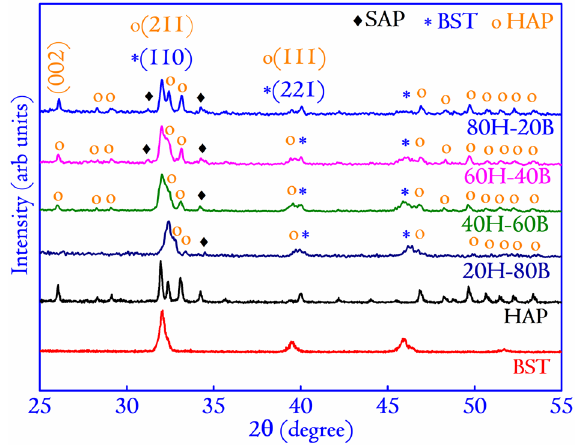
Figure 2. XRD patterns of the composites showing the peaks corresponding to both the monoliths along with the appearance of additional peaks corresponding to the SAP phase. The XRD patterns of the monoliths are also presented along with the composites. The patterns reveal a large extent of overlapping in the peaks due to the closeness of the Bragg’s angle in those positions. The dominance of the planes in the composite is observed, which corresponds to the more significant concentration of the monoliths. The (hkl) planes are identified by comparing the planes with the standard ICDD files: card no. # 39-1395 for BST, # 009-0432 for HAP, and card no # 002-0761 for